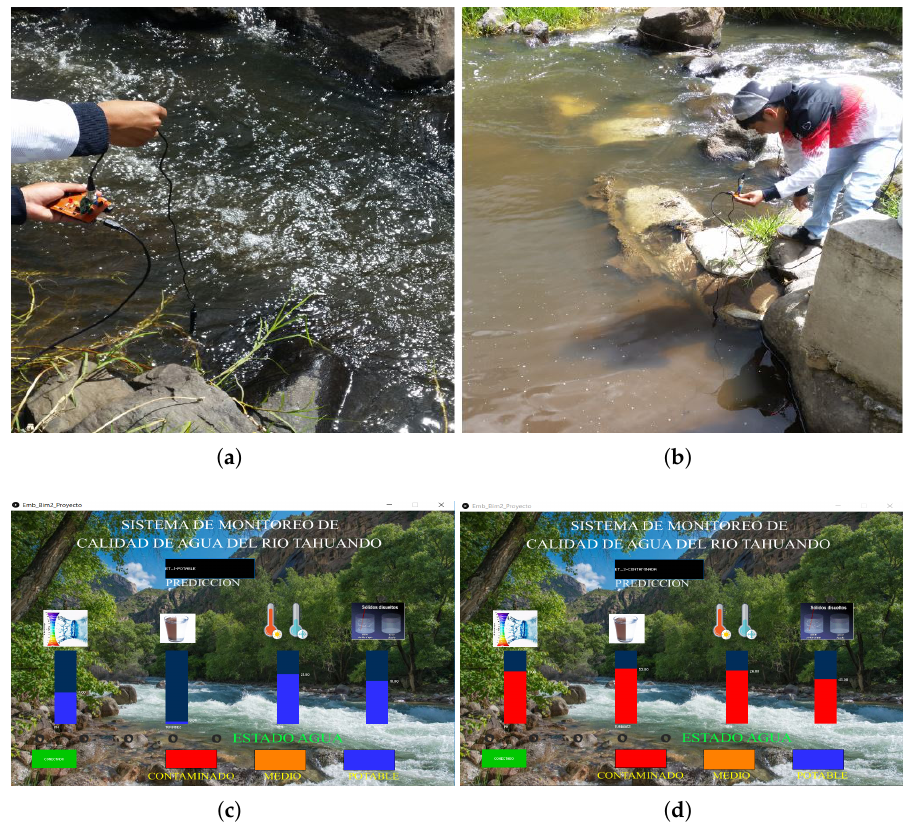
Figure 10. System testing and visual interface. ( a ) Testing embedded system developed in the rural sector. ( b ) Testing embedded system developed in urban sector. ( c ) Visual interface showing low level of contamination. ( d ) Visual interface showing high level of